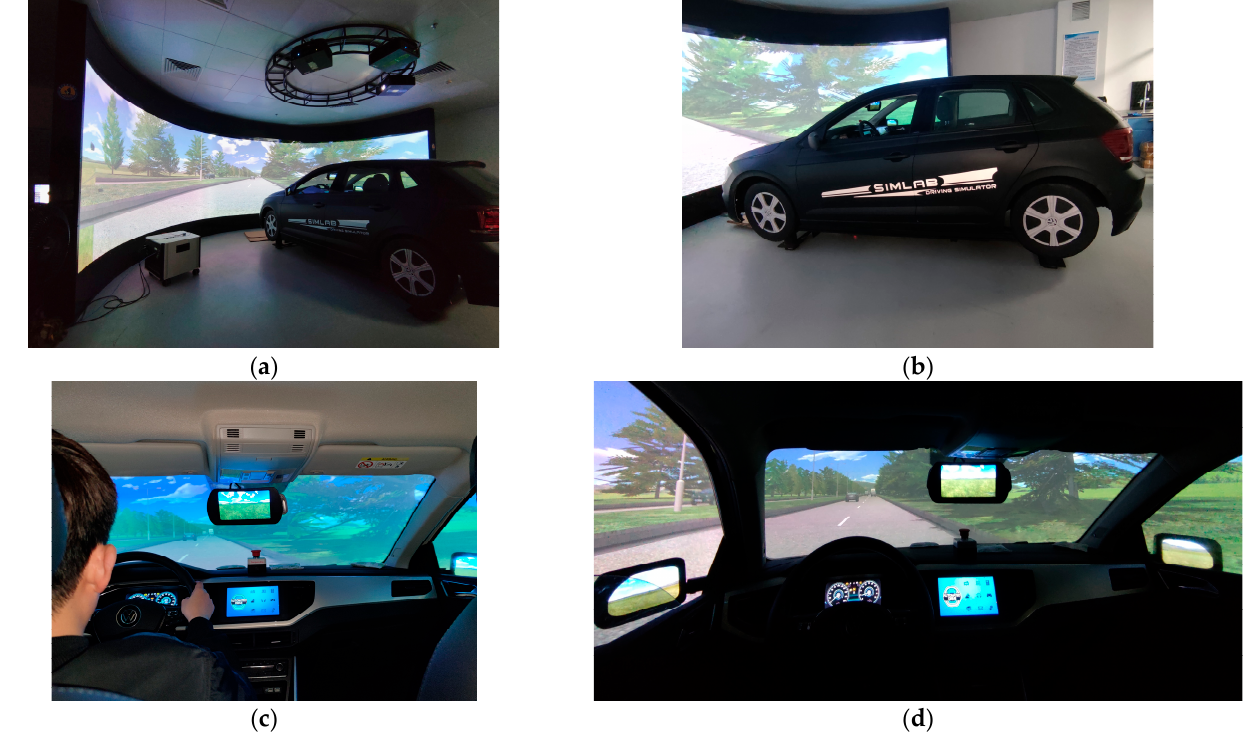
Figure 4. The motion-base driving simulators. ( a , b ) Outside, ( c , d ) Inside.